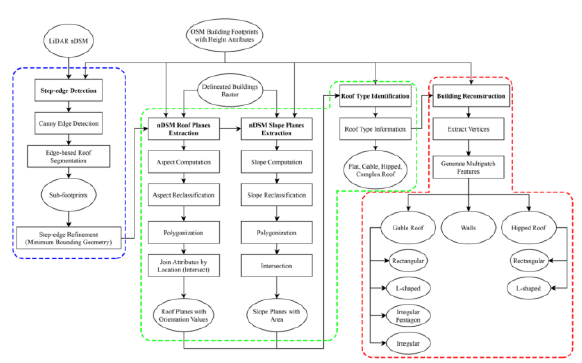
Figure 3. LOD2 Building Reconstruction